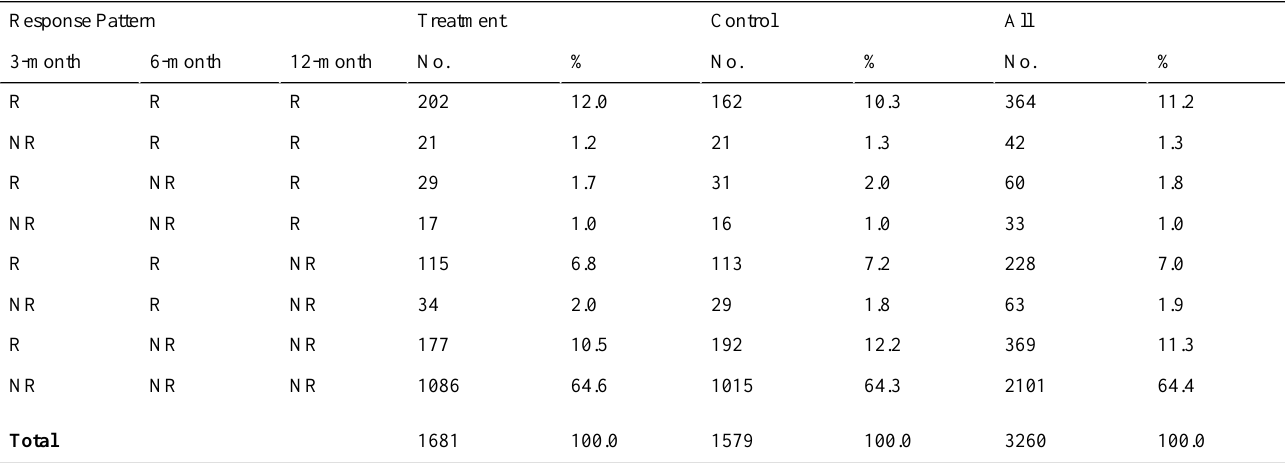
Table 1. Response pattern to three online follow-up surveys AllControlTreatmentResponse Pattern %No.%No.%No.12-month6-month3-month